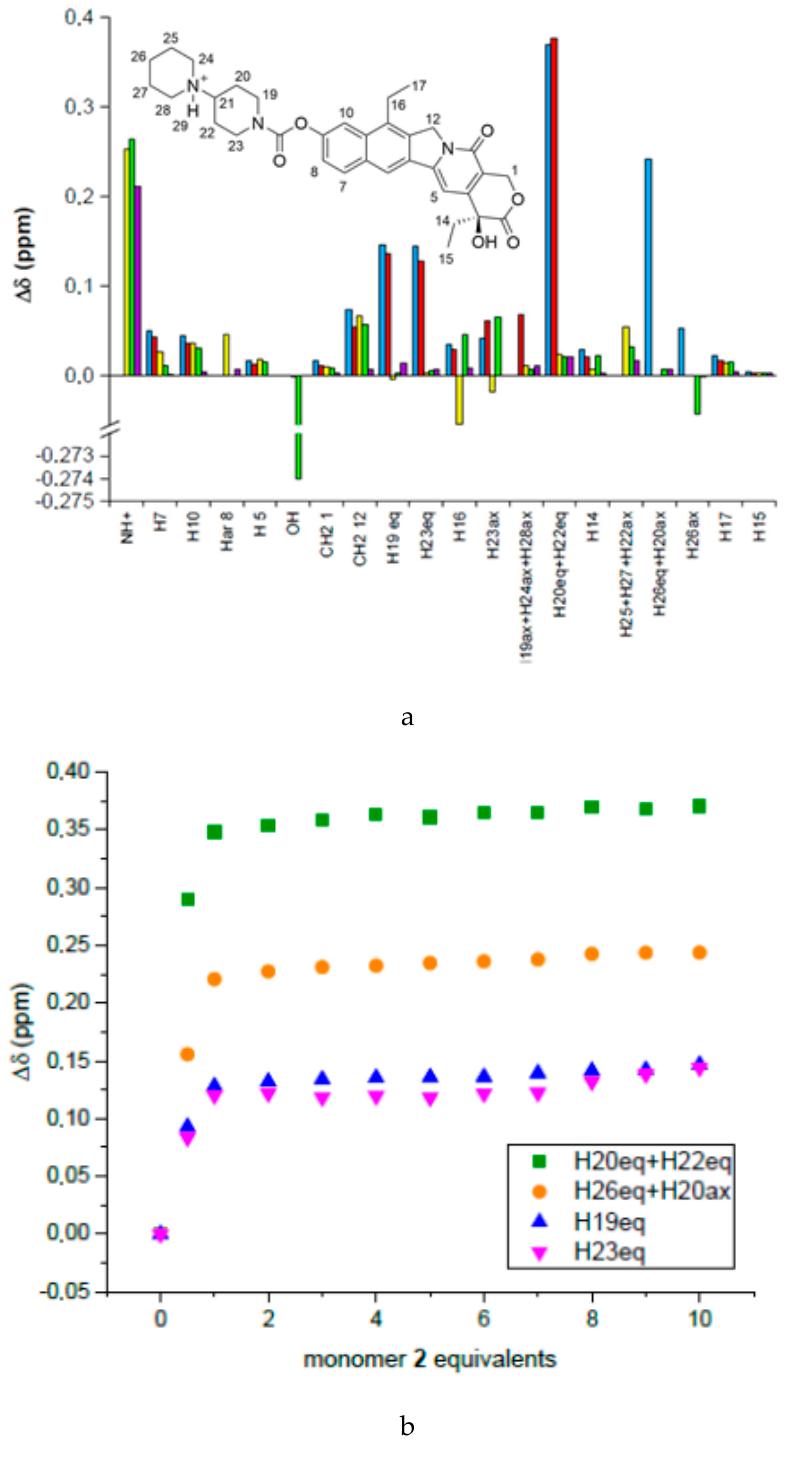
Figure 2. ( a ) Variation of chemical shifts of irinotecan protons after adding 10 equivalents of monomer 2 (yellow), 3 (cyan), 4 (blue), 5 (red), and 6 (green); ( b ) variation of chemical shift of selected irinotecan protons upon titration with monomer 5.